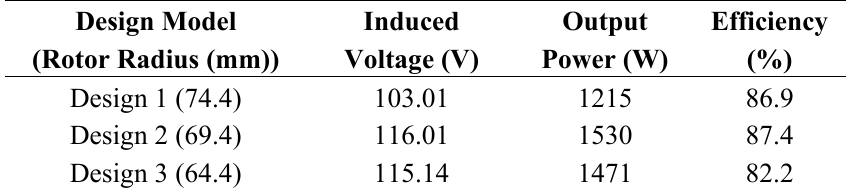
Table 3. Output power and